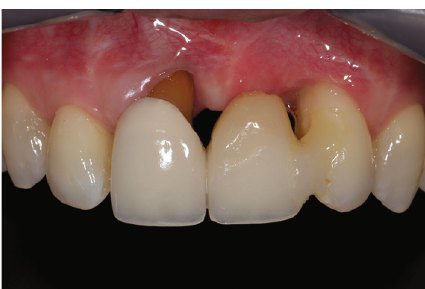
Figure 12: Healing after 6 months. Incomplete soft-tissue augmentation is evident.